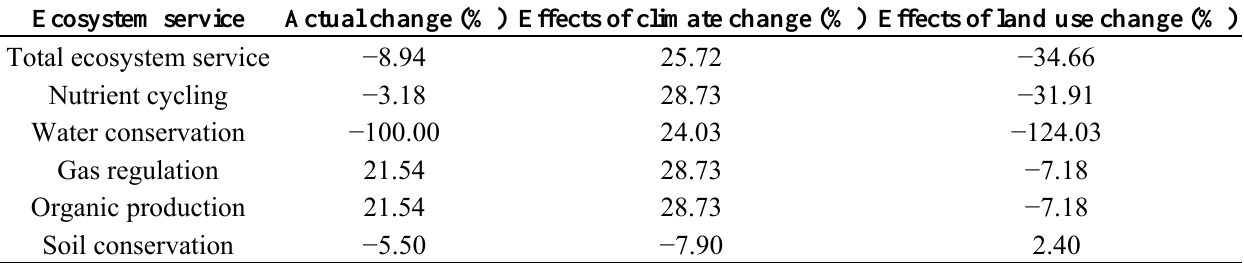
Table 3. Effects of climate and land use change on ESV in the NCP between 1988 and